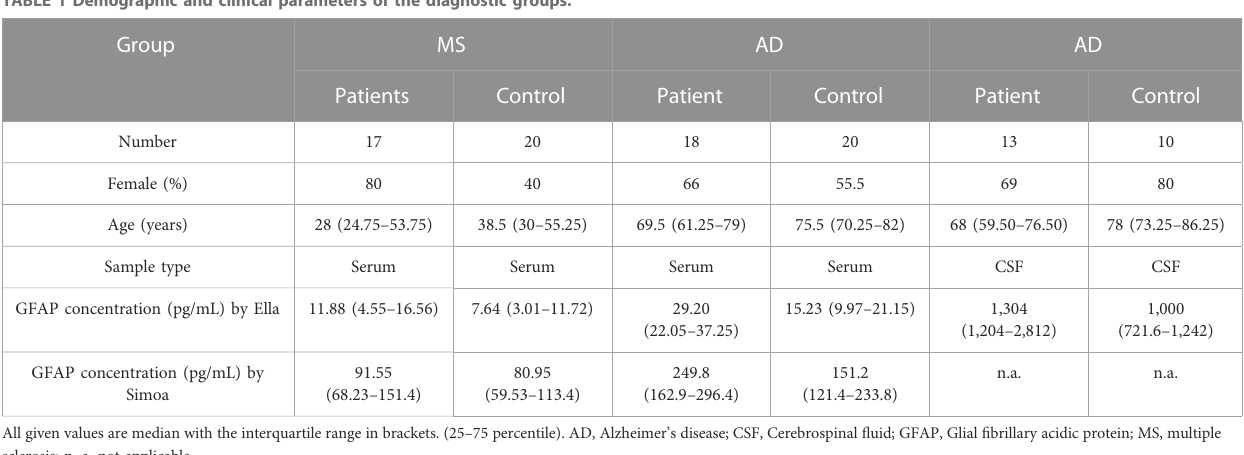
TABLE 1 Demographic and clinical parameters of the diagnostic groups.